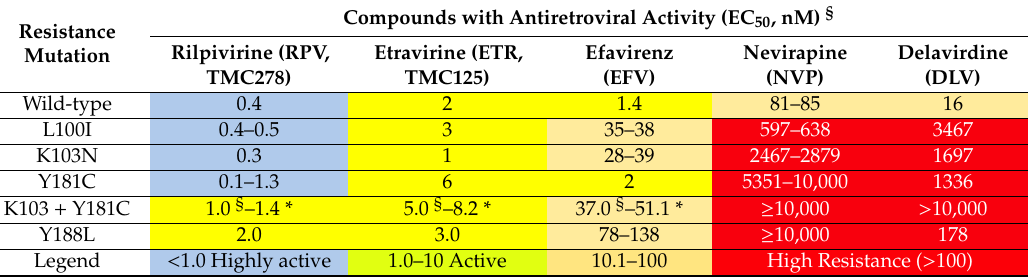
Table 1. Non-nucleoside reverse transcriptase inhibitor (NNRTI) antiretroviral potency against wild-type and some mutant reverse transcriptases